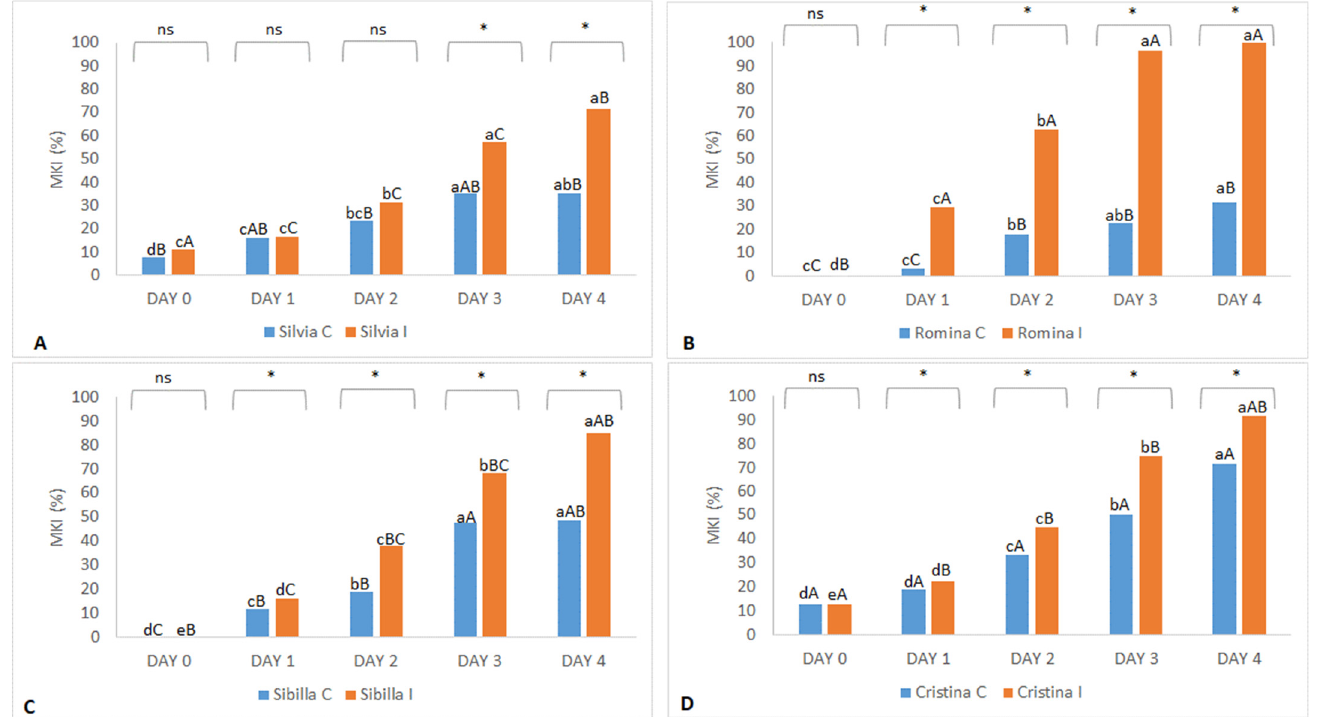
Figure 2. McKinney index (MKI) of postharvest decay of the ( A ) Cristina, ( B ) Romina, ( C ) Sibilla, and ( D ) Cristina strawberry fruits in the 2020 harvest season. Blue bars represent the control samples (not infected), and orange bars represent the infected samples (with B. cinerea spores). Strawberries were stored for 4 days at 20 ± 1 °C, and 90% relative humidity. Different lowercase letters indicate a significant difference ( p ≤ 0.05, Tukey test) between fruits of the same treatment of the same cultivar at different days. Asterisks indicate a significant difference ( p ≤ 0.05, Tukey test) between control and infected fruits of the same cultivar at the same days (ns: not significant). Different uppercase letters indicate a significant difference ( p ≤ 0.05, Tukey test) between fruits of the same treatment of different cultivars at the same days.